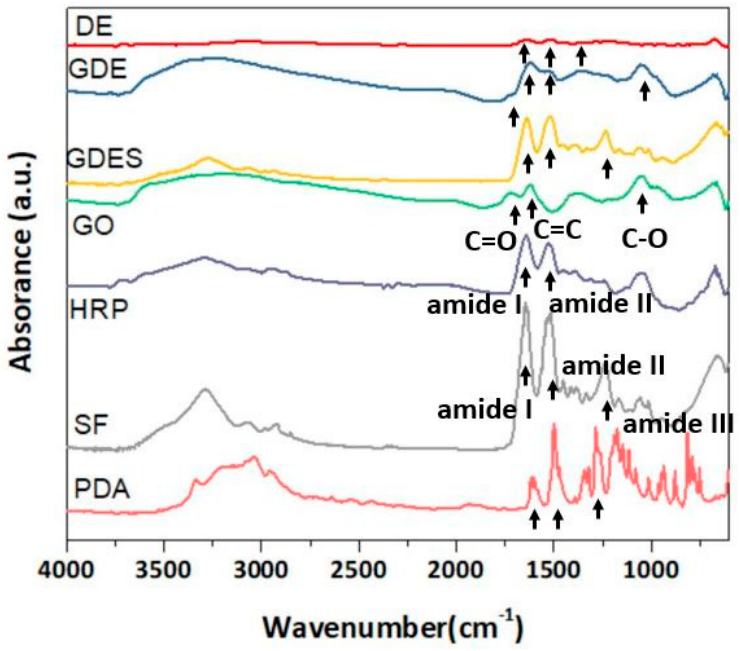
Figure 2. ATR-FTIR absorption spectra of varying composites of GDES films including DE, GDE, GDES, GO, HRP (E), PDA (D), and SF (S) were shown. The characteristics of the spectra of GDES films were mainly influenced by SF such as amide I, II and III since they contained large amounts of SF.